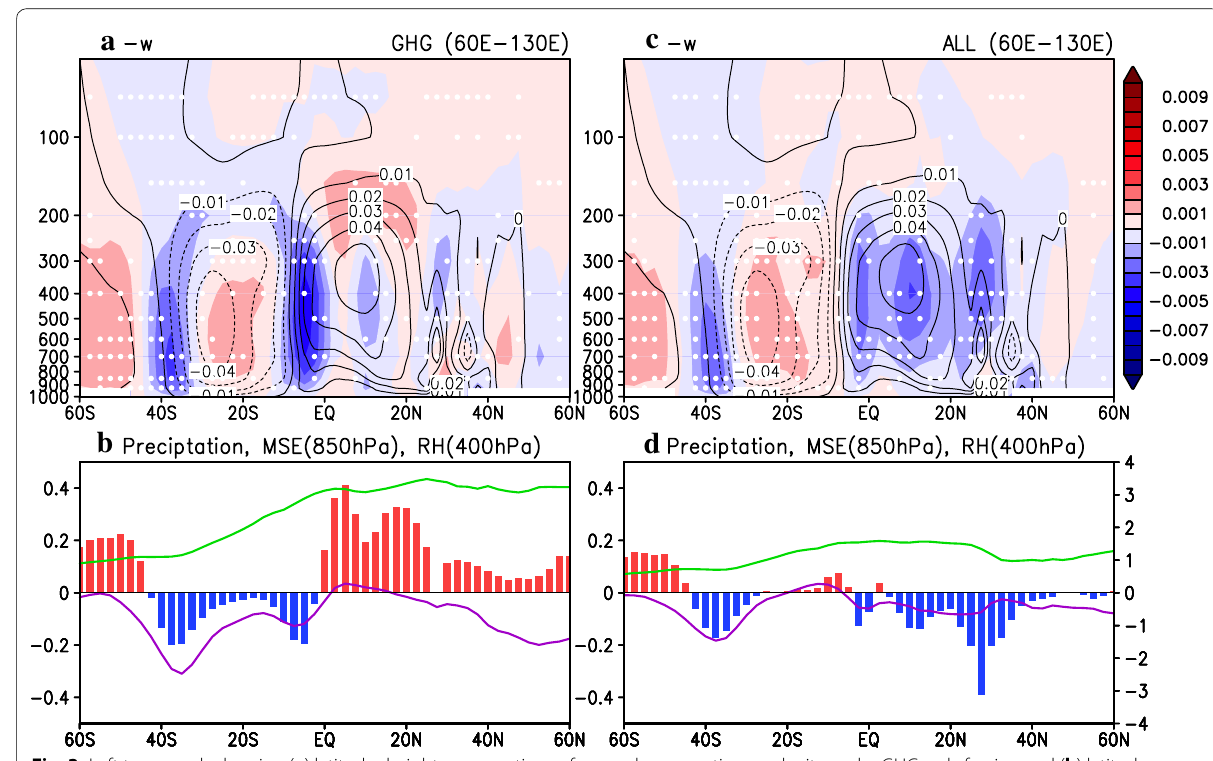
Fig. 3 Left two panels showing ( a ) latitude–height cross‑sections of anomalous negative p‑velocity under GHG‑only forcing and ( b ) latitude profiles of anomalies of rainfall (histogram) in mm day − 1 (left ordinate), 850 hPa MSE (green line) in kJ (right ordinate), and 400 hPa RH (purple line) in percentage (right ordinate). Contours represent climatology. Left two panels c and d are the same as a and b , except for ALL. White dots indicate grid points where 12 or more out of the 19 models agree in the sign of the